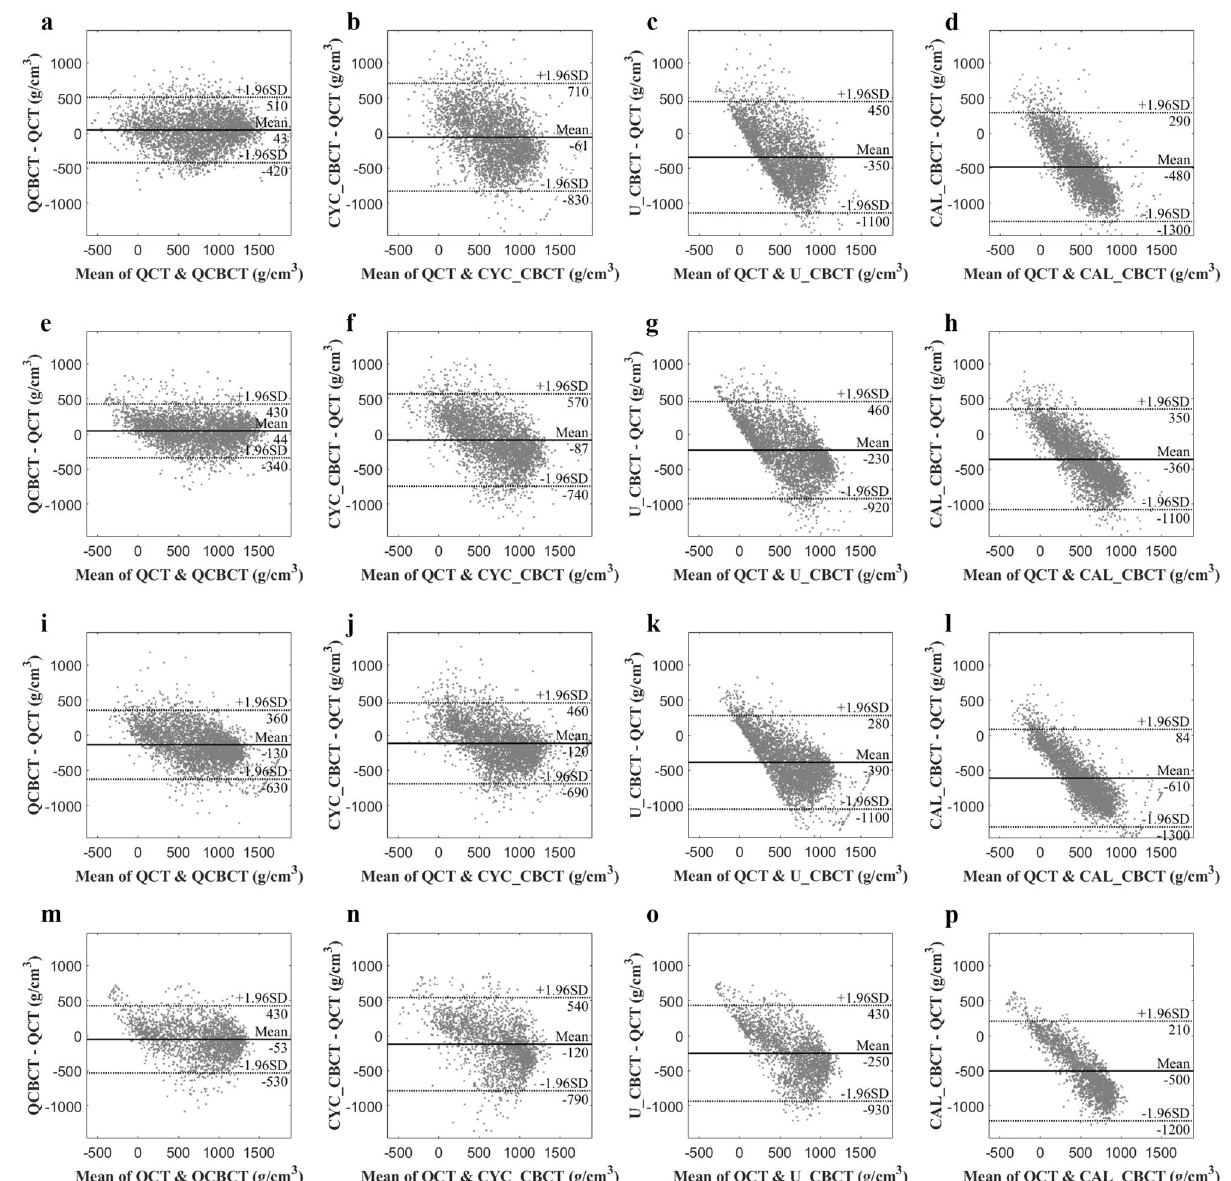
Figure 7. The Bland–Altman plots between the original QCT, and QCBCT, CYC_CBCT, U_CBCT, and CAL_ CBCT images. ( a–d ) CBCT images at the maxilla under condition of 80 kVp and 8 mA, ( e–h ) at the mandible under condition of 80 kVp and 8 mA, ( i–l ) at the maxilla under condition of 90 kVp and 10 mA, and ( m–p ) at the mandible under condition of 90 kVp and 10